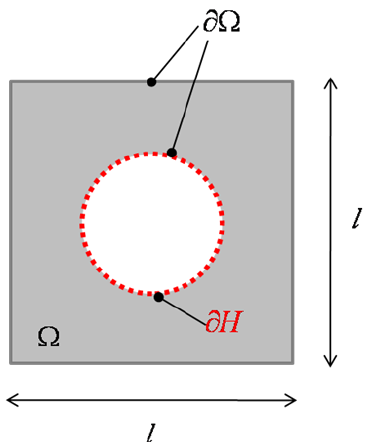
Figure 1: Porous NiTi SMA periodic unit cell.